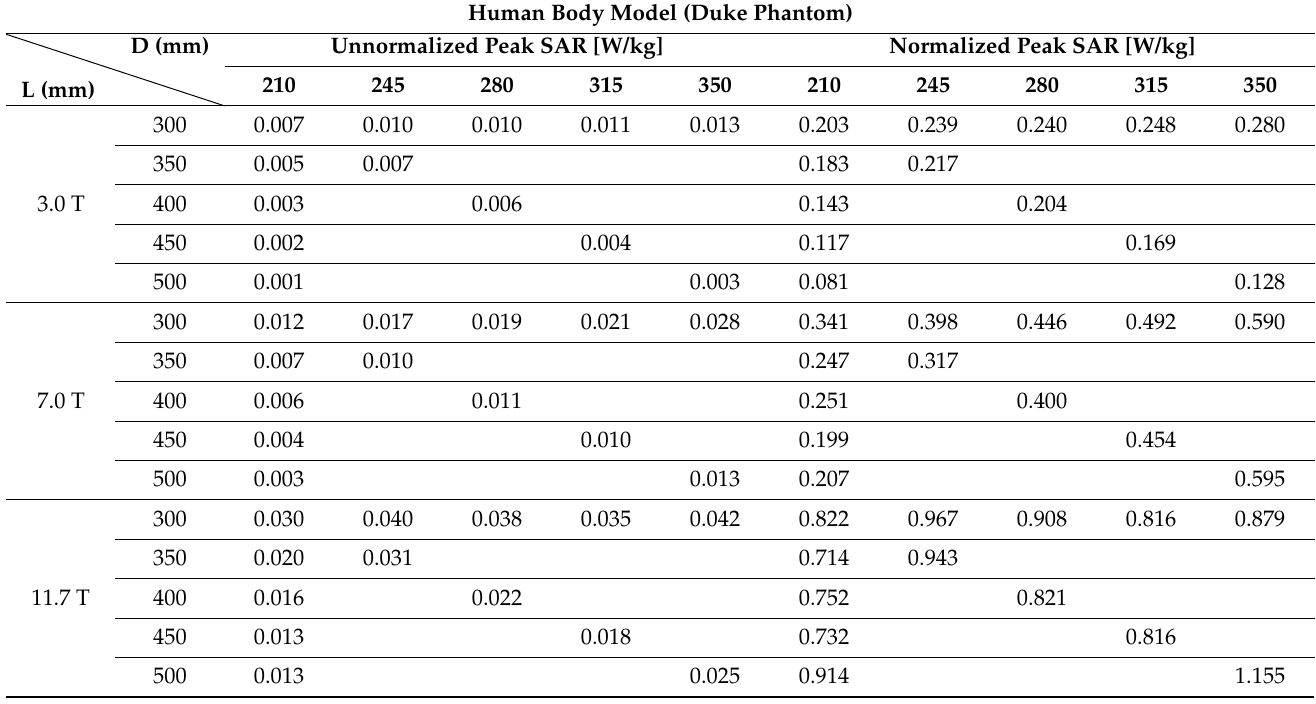
Table 3. Peak SAR values under unnormalized and normalized conditions at a 3.0, 7.0, or 11.7 T MRI